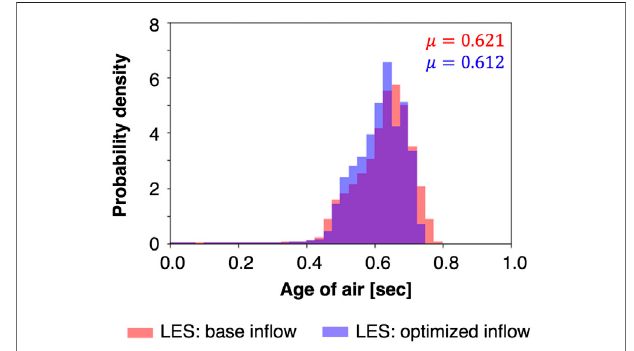
FIGURE 12 | Frequency distribution of age of air using two different in fl ow conditions.